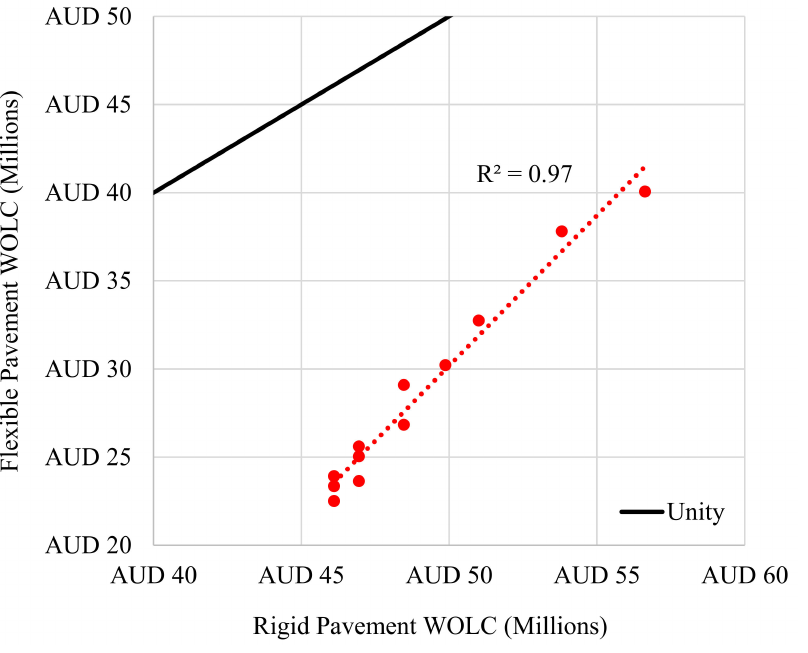
Figure 4. Forty-year 5% discount WOLC comparison.